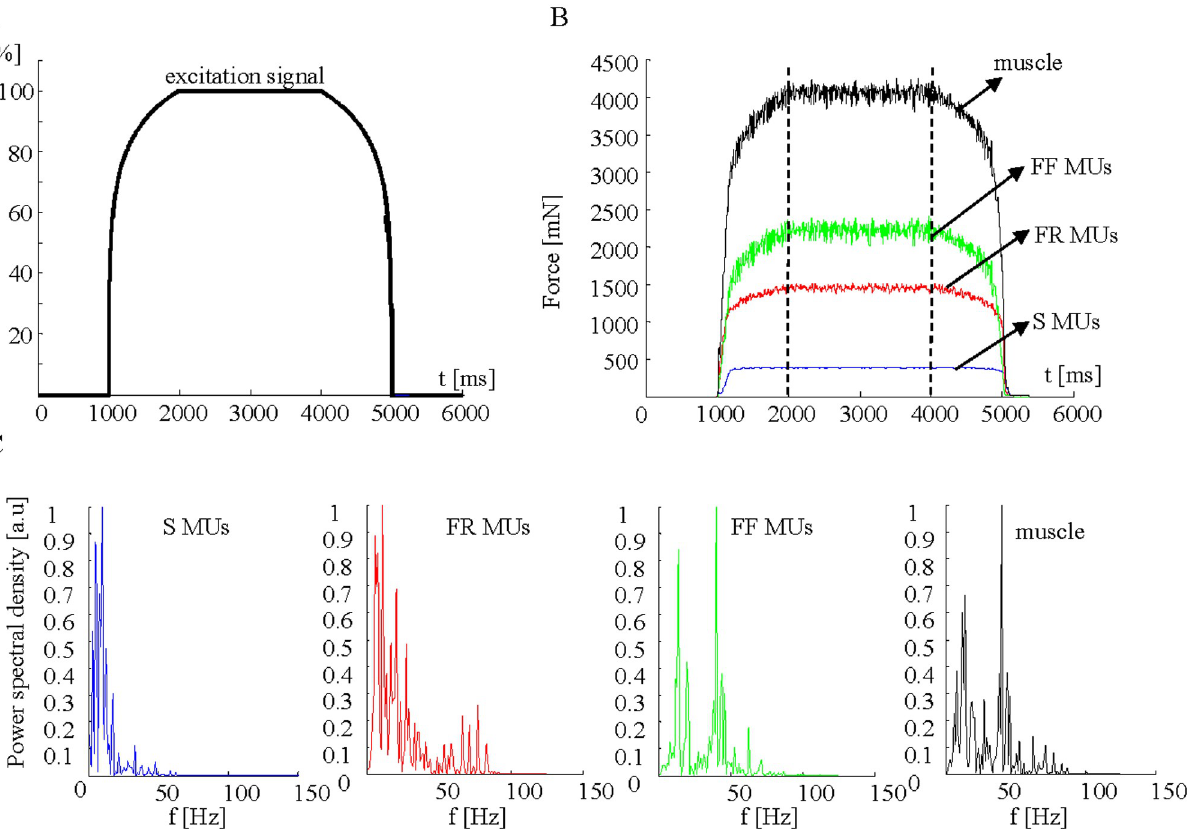
Fig 1. Parameters of the basic model, calculated using a 100% excitation signal. A. The law for the excitation. B. The calculated forces of populations of different MU types (S, FR, and FF) and the muscle. C. Normalized power spectral density of the force during a time period of 2000 to 4000 ms, presented separately for individual MUs (S, FR, and FF) and the whole